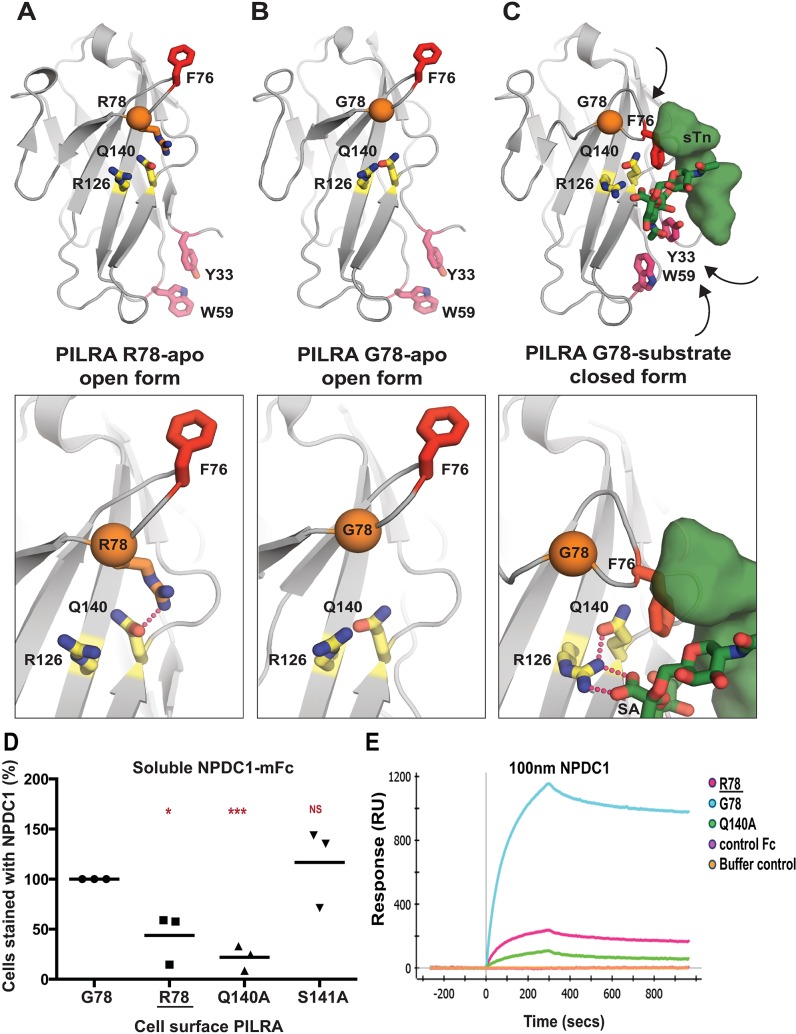
Structural determinants of PILRA in apo and ligand-bound conformations.A) The unliganded crystal structure of R78 (AD protective) PILRA (PDB 4NFB) displays an “open” conformation with an unformed sialic acid (SA) binding site. B) The apo crystal structure of G78 (AD risk) PILRA (PDB 3WUZ) reveals that the Q140-R126 interaction network (productive for SA-coordination) is pre-formed and the “downward” movement of F76 is not impeded in the R78 side chain mediated interactions. C) The sialylated O-linked sugar T antigen (sTn)-bound PILRA structure (PDB 3WV0) reveals the ligand-induced conformational changes across the receptor that lead to engagement of the SA-motif by direct coordination to R126 and the critical involvement of F76 in peptide (sTn ligand) recognition. Aromatic residues including Y33 (fuchsia) and W59 (fuchsia) also undergo significant ligand-induced conformational changes. D) 293T cells were transfected with G78 (AD risk) PILRA and several point mutants of PILRA. Binding of NPDC1-mFC to PILRA variant-transfected cells was measured by flow cytometry. The percent of cells expressing PILRA and positive for NPDC1 is indicated in each panel considering G78 PILRA binding as 100% for each experiment. Statistical analysis is two-tailed unpaired t-test. E) Binding of NPDC1.mFC to PILRA variants by surface plasmon resonance (SPR).